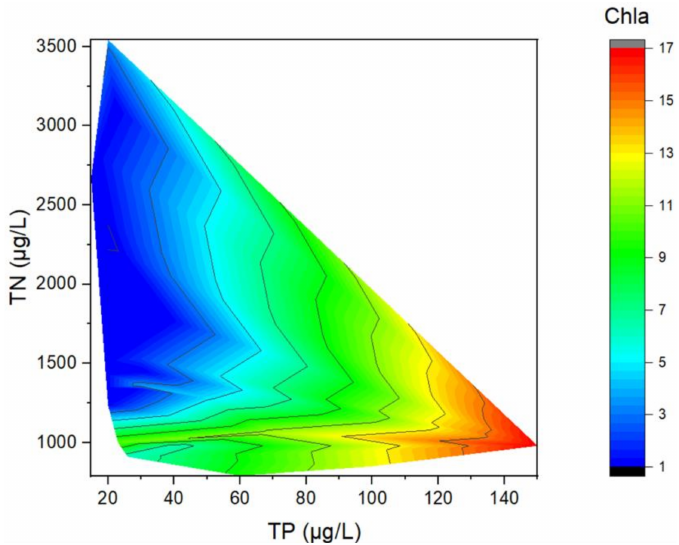
Figure 5. Contour plot of the Chaihe Reservoir showing the distribution of Chl a across different TP and TN